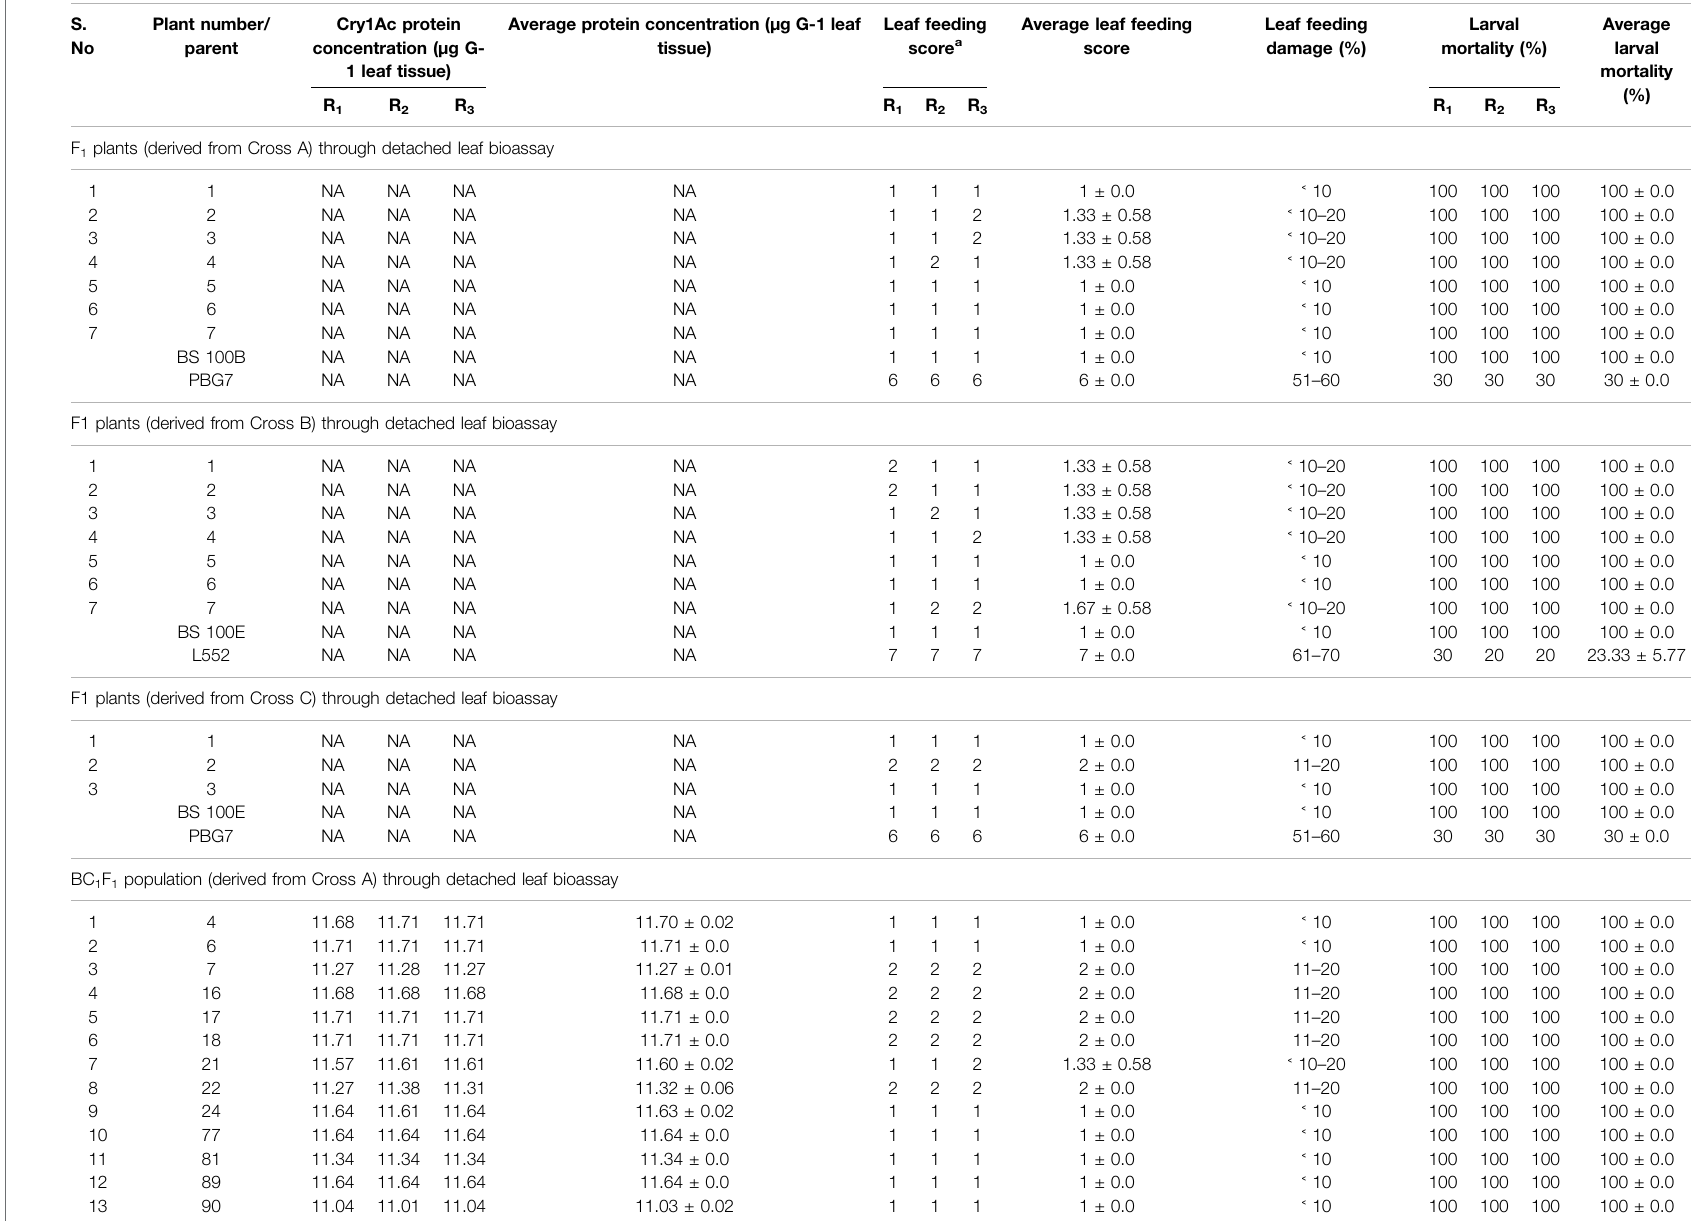
TABLE 1 | Bioassay on F 1 plants and backcross populations raised by crossing commercial chickpea cultivars with cry1Ac transgenic lines for toxicity to H . armigera neonatal larvae. S. Plant number/ No